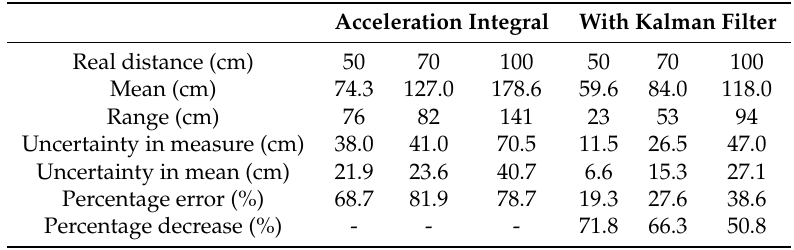
Table 1. Displacement along the x -axis measured with the Waspmote.